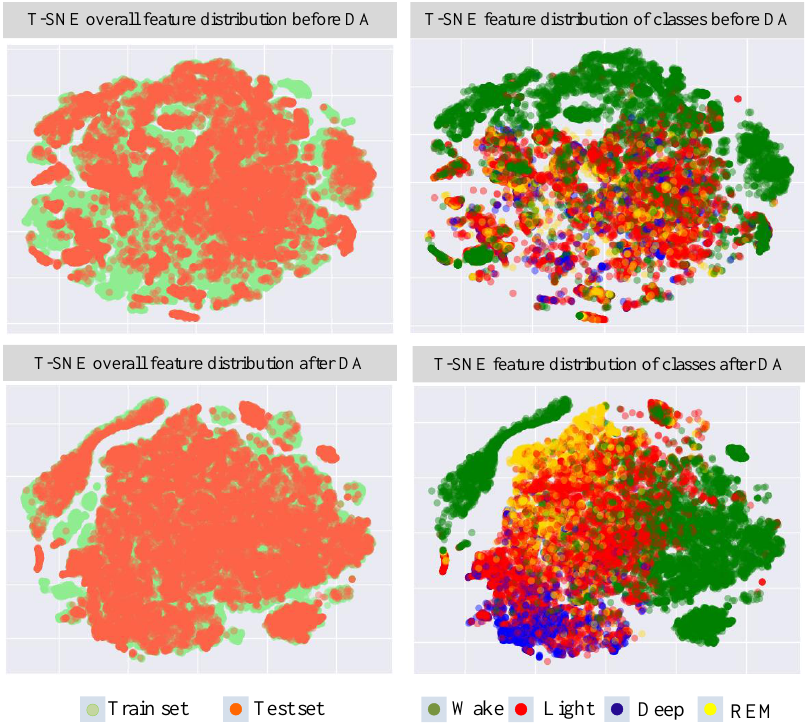
Figure 5. T-SNE results of SHHS2′s feature distribution extracted by the CNN block module before DA and after DA. Table 3. Results of sleep stage classification on the test sets.